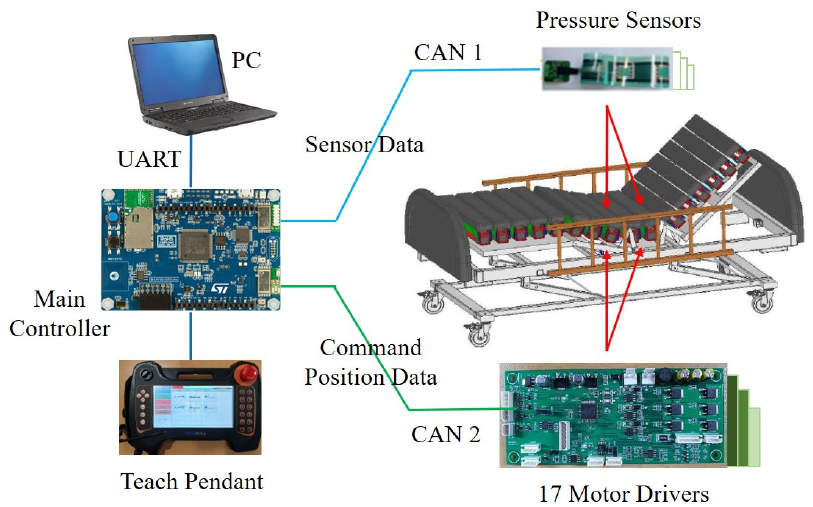
Figure 8. Structure of the control system.